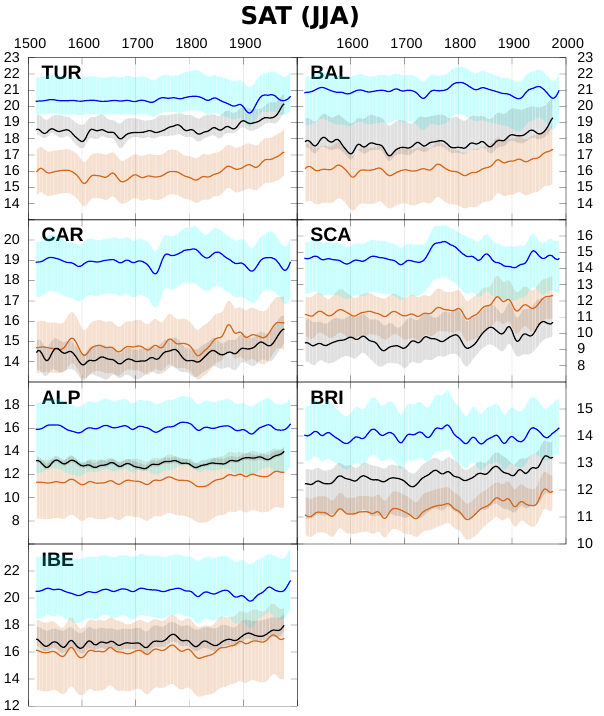
Figure 3. As Fig. 2 but for simulated summer SAT.